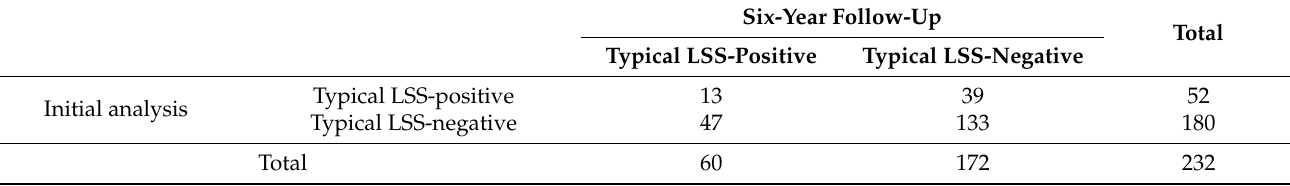
Table 2. Time course of LSS symptoms.